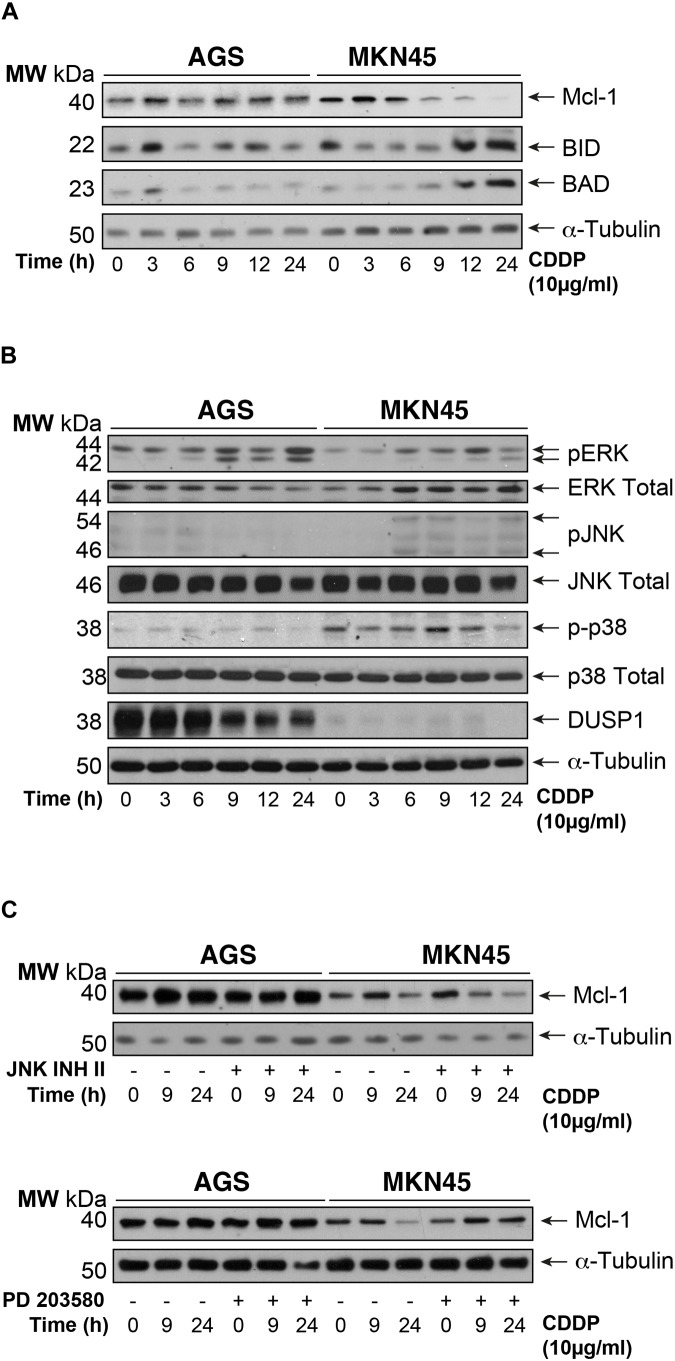
Intrinsic apoptosis pathway by CDDP is mediated by Mcl-1 in MKN45 cells. (A) Bcl-2 protein family members were detected by western blot in AGS and MKN45 cells treated with CDDP (10 μg/ml) at the indicated periods of time. Mcl-1, Bid, and Bad were detected by using specific antibodies. (B) Cells were treated as in panel (A). ERK, JNK, p38 (phosphorylated and total forms), and DUSP1 expression were detected by using specific antibodies. (C) AGS and MKN45 cells were pretreated during 30 min with 10 μM JNK Inhibitor II or p38 inhibitor (SB203580) before CDDP treatment. Mcl-1 was detected by western blot at the indicated times after treatment. α-Tubulin was used as loading control. WB images are representative of the results obtained in three different experiments made in the same conditions.